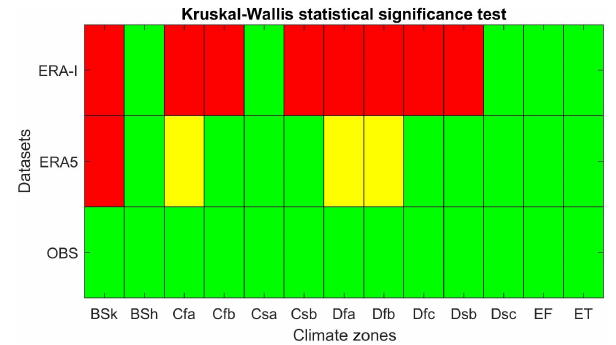
Figure 11. Results of the Kruskal–Wallis statistical significance test to determine the best dataset for hydrological modelling as observed through the KGE metric, for each climate zone. The green, yel- low and red colours, respectively, indicate the best, second best and worst datasets for each climate